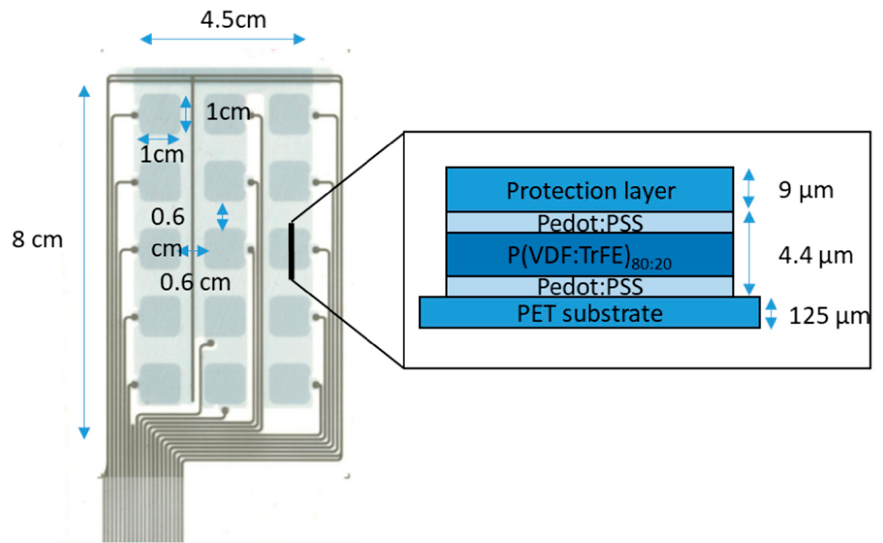
Figure 2. Top view of the sensor matrix and schematic of the layer stacking in one of the pixels (the